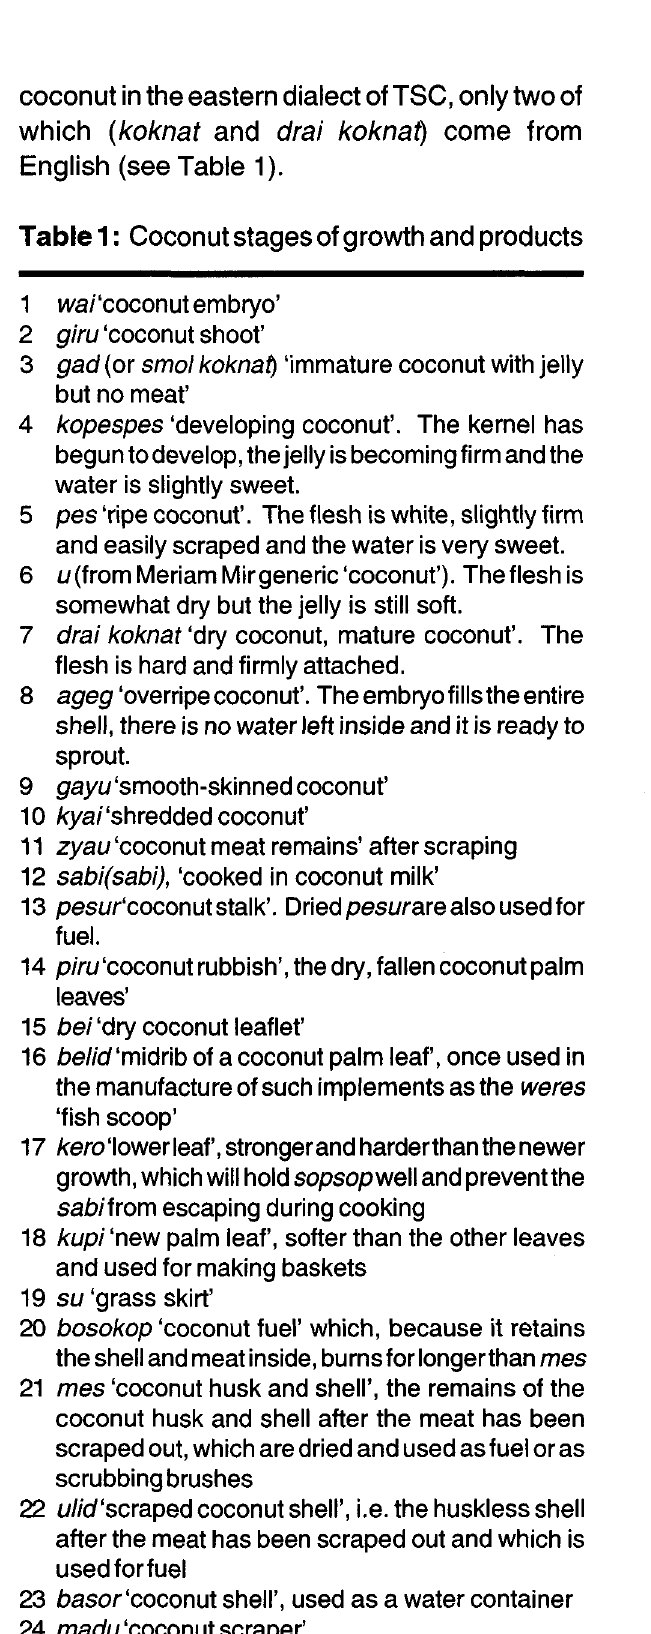
Table 1 : Coconut stages of growth and